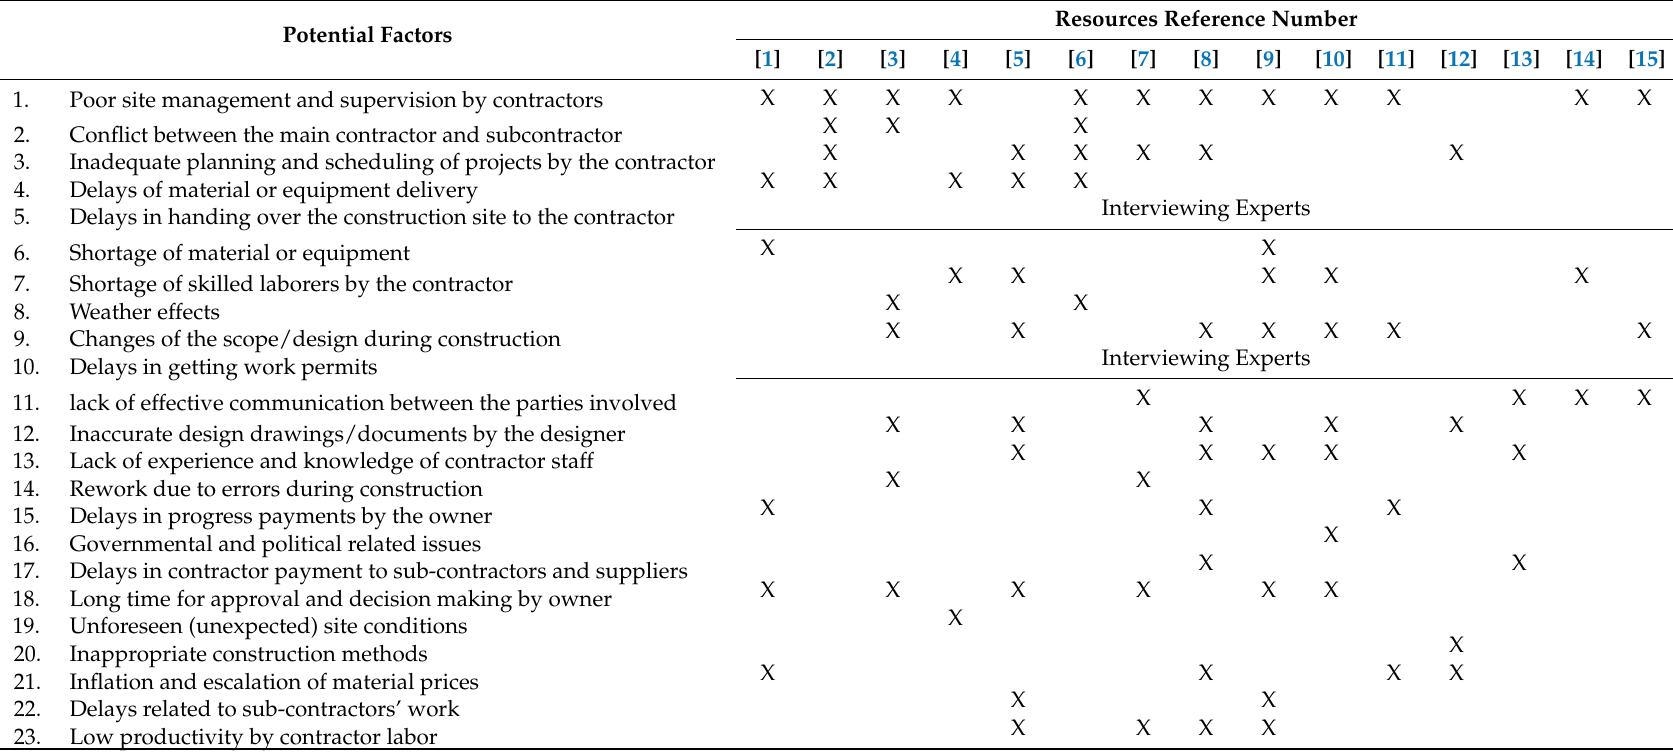
Table 1. The summary of the factors drawn from the literature and local